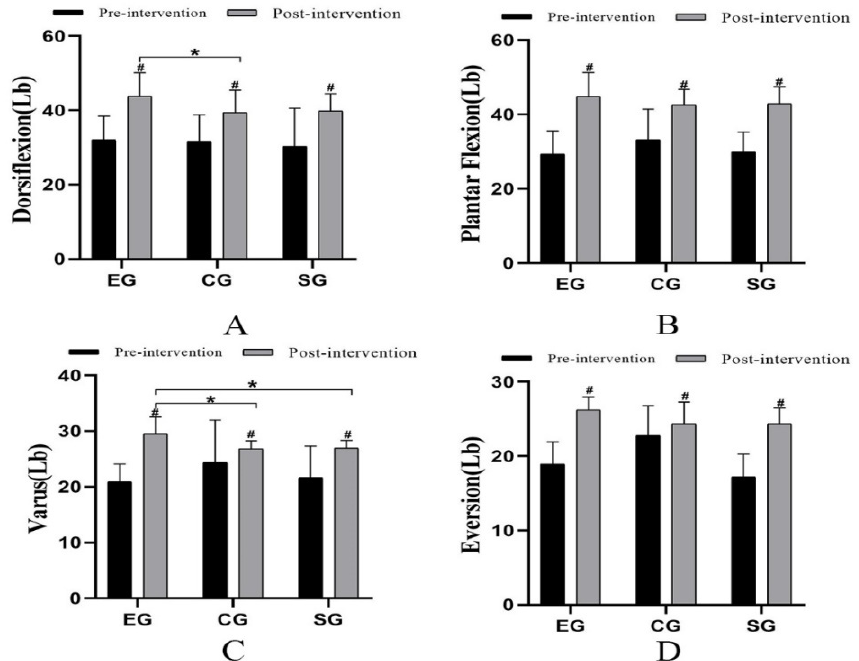
Figure 4. Comparison of muscle strength (Lb) among the three groups. # Comparison between groups; * Significant when compared with the EG group ( p < 0.05). ( A : Ankle dorsiflexor strength; B : Ankle plantar flexion strength; C : Ankle varus strength; D : Ankle eversion strength)